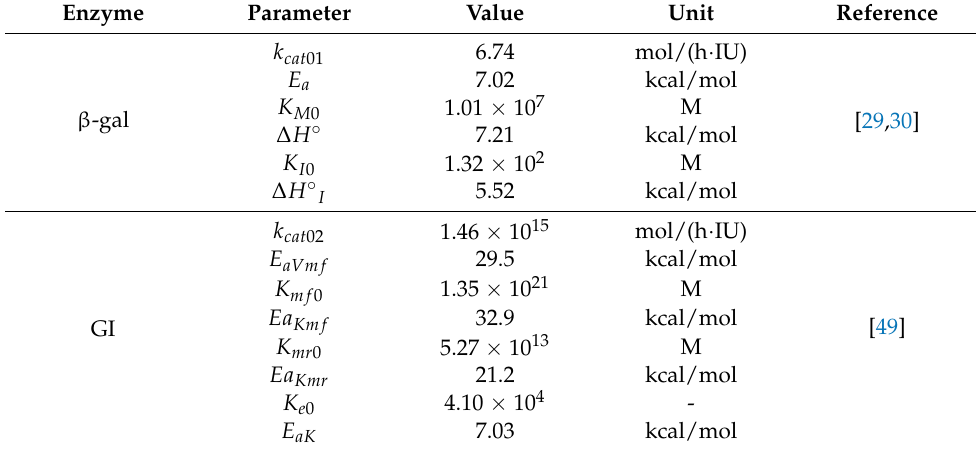
Table 1. Values of the kinetic parameters of β -gal and immobilized GI used in the simulation of the production of lactofructose